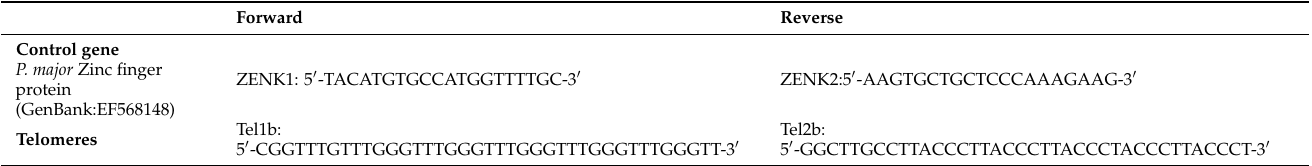
Table A3. Primers Sequence for qPCR RTL Analysis.